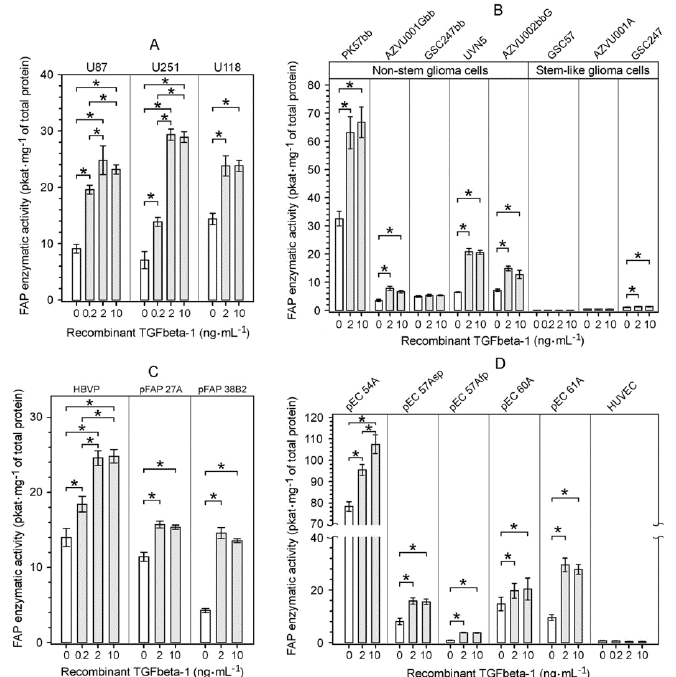
Figure 4. Upregulation of FAP enzymatic activity by human recombinant TGFbeta-1 protein in different cell types originating from human glioblastomas (GBMs). The cells were cultured in the absence or presence of recombinant TGFbeta-1 for 72 h and their lysates were assayed for FAP enzymatic activity and total protein concentration. ( A ) Upregulation of FAP enzymatic activity in TGFbeta-1-treated permanent glioma cell lines. ( B ) Upregulation of FAP enzymatic activity in TGFbeta-1-treated non-stem glioma cell cultures, but absence of or negligible increase in FAP enzymatic activity in TGFbeta-1-treated glioma stem-like cell cultures. ( C ) Upregulation of FAP enzymatic activity in TGFbeta-1-treated human brain vascular pericytes (HBVP) and glioblastoma- derived FAP + mesenchymal (pFAP) cell cultures. ( D ) Upregulation of FAP enzymatic activity in TGFbeta-1-treated endothelial cell (pEC) cultures isolated from human GBMs, but not in human umbilical vein endothelial cells (HUVEC). Results are presented as mean ± SD from six parallel cell cultures measured in triplicate. In ( A – D ), * p < 0.05, one way ANOVA, Tukey’s post hoc